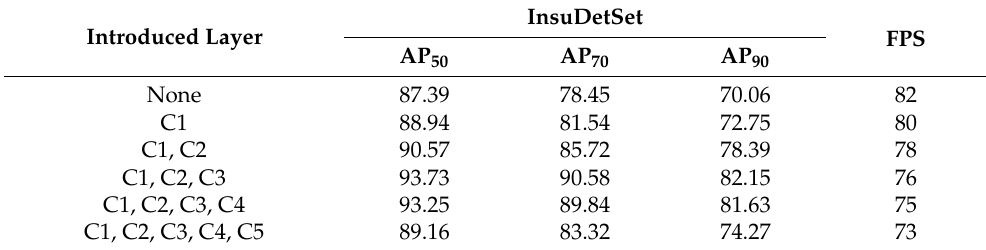
Table 7. APs of different introduction times of the attention mechanism.